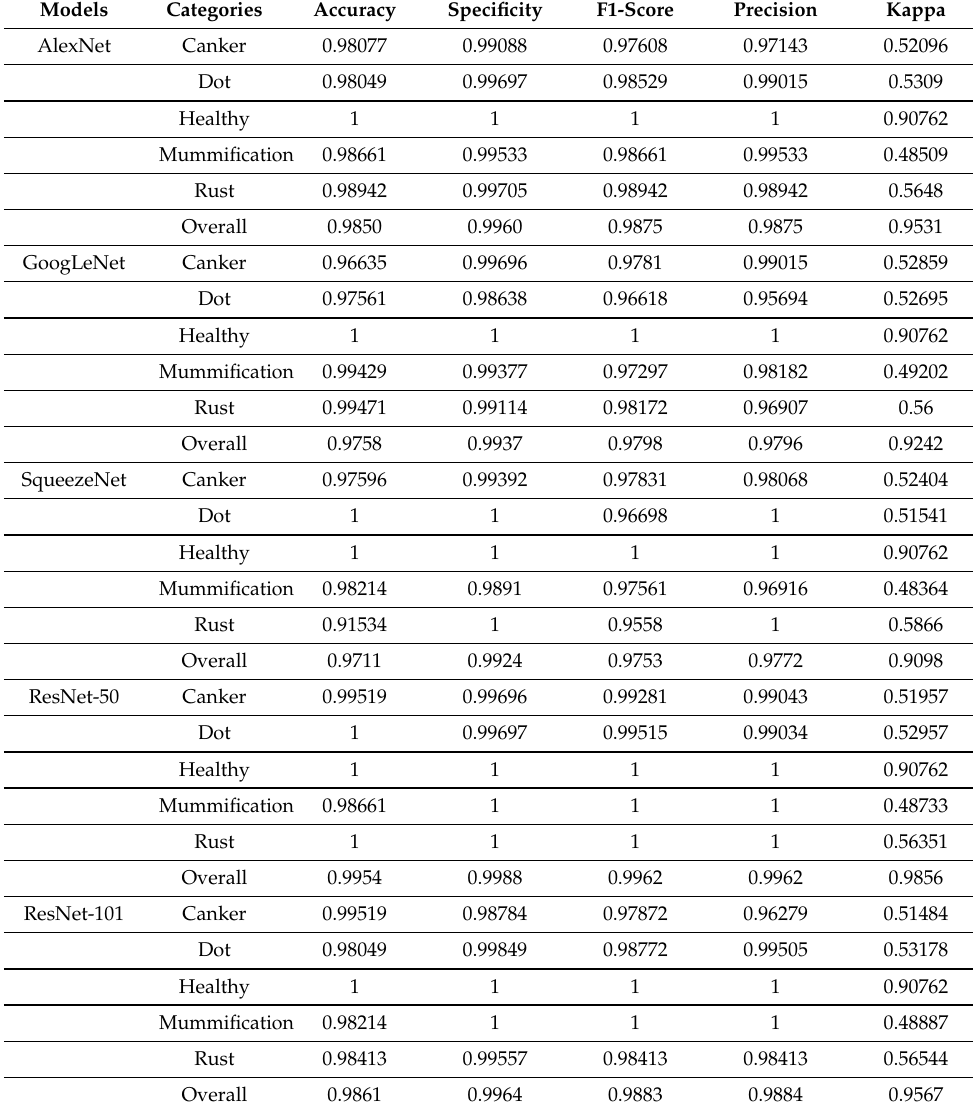
Table 7. Results obtained on the basis of individual class testing